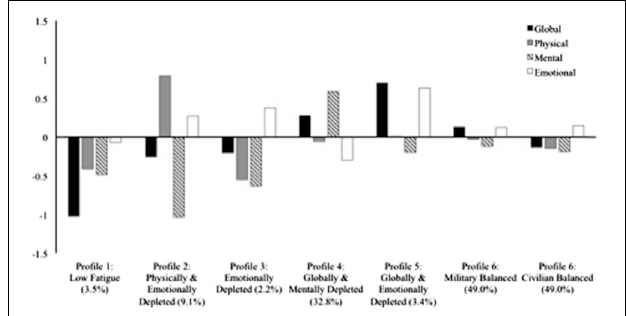
FIGURE 1 | Final six-profile solution of distributional similarity. Profile indicators are factor scores with a mean of 0 and a standard deviation of